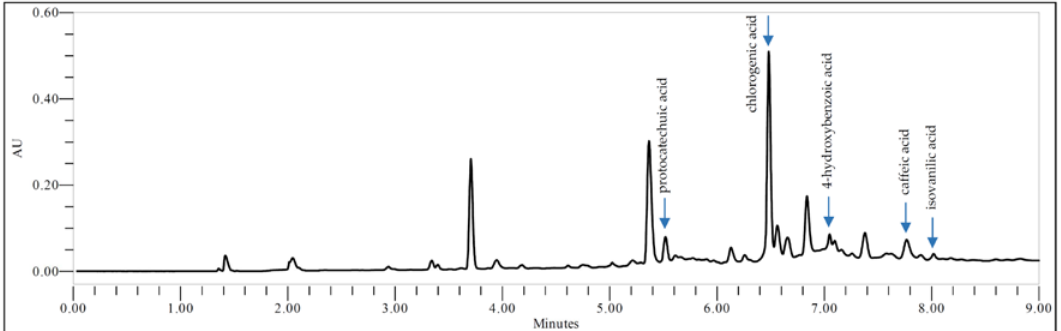
Figure 1. SPE-UPLC fingerprint of the G. parviflora extract (GP).